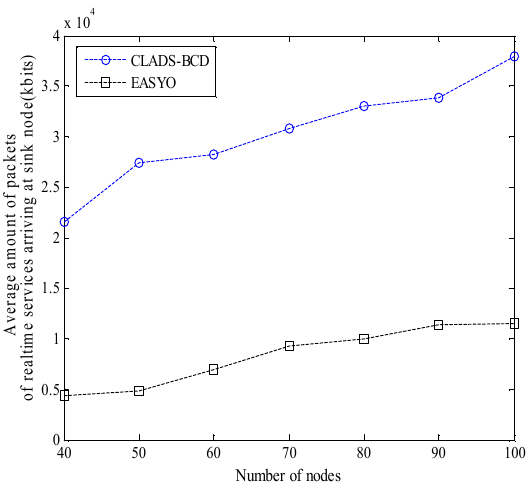
Figure 11. Average number of packets of real-time services arriving at the sink